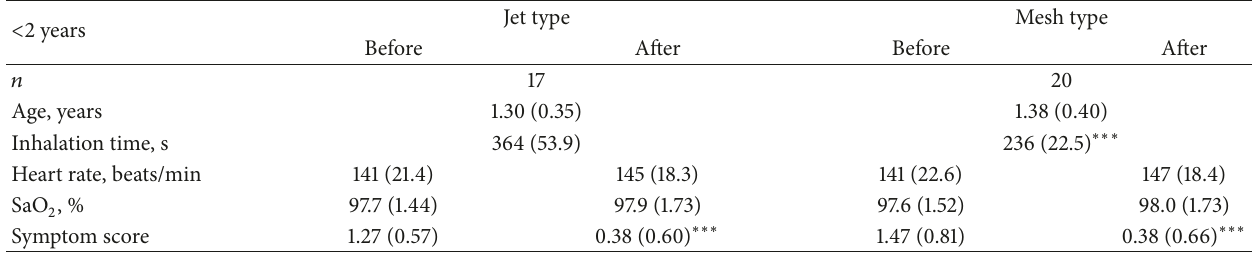
Table 2: Clinical examinations before and after treatment for children < 2 years